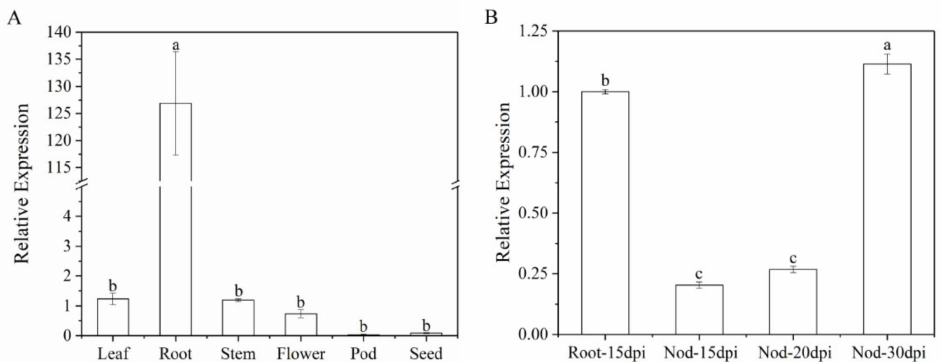
Figure 5. Expression of MtWRP1 in M. truncatula : ( A ) The transcript levels of MtWRP1 in different plant organs. Young leaves, stems, and roots were collected from 4-week-old plants. Flowers were sampled from 8-week-old plants. Pods at pod-bearing period and seeds at seed-filling period were collected from 90-day-old plants. ( B ) The transcript levels of MtWRP1 in nodules (Nod 15, 20, and 30 dpi) inoculated with S. mliloti 1021. The gene expression in root at 15 dpi (Root-15 dpi) was used as control. Data represent mean ± SD ( n = three independent biological replicates). Different letters above the standard error bars indicated a significant difference between the simples as determined by Duncan’s multiple range test ( p <